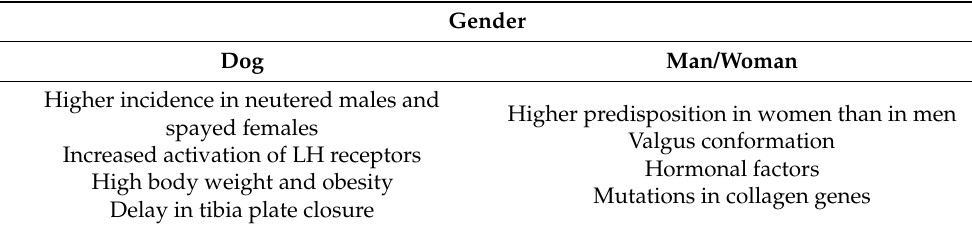
Table 2. Differences between dogs and humans for CrCL rupture in relation to gender